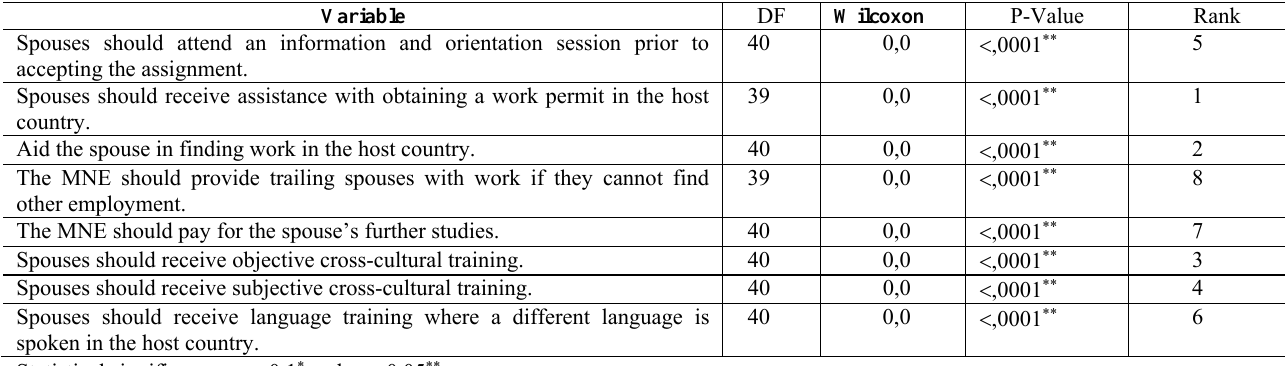
Table 5: Wilcoxon test for required vs. provided for trailing spouses Variable DF Wilcoxon P-Value